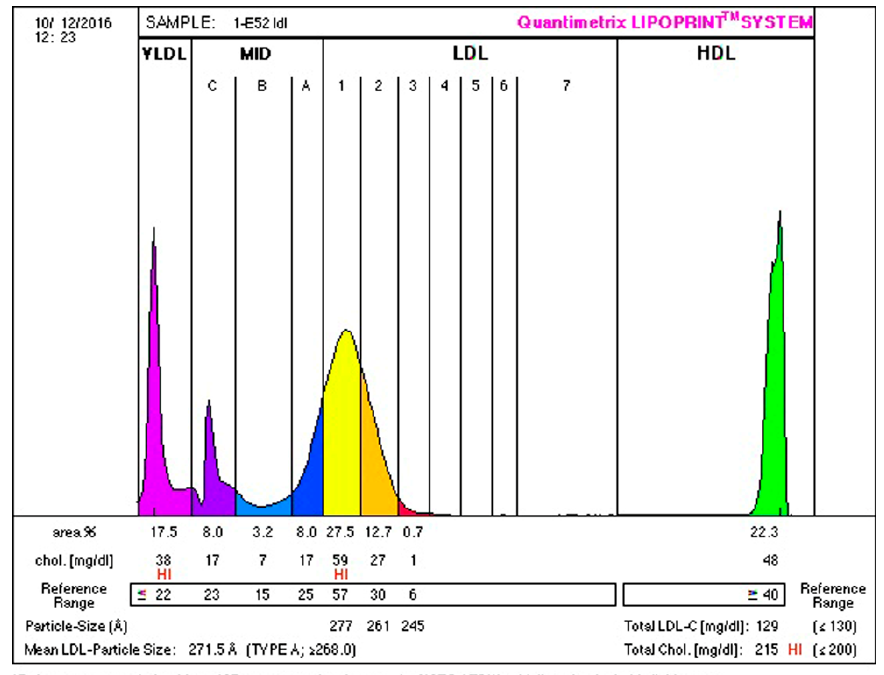
Figure 3. Low-density lipoprotein cholesterol (LDL-C) separation before therapy, indicating 17.5% of very-low-density lipoprotein (VLDL; purple), 19.2% of intermediate-density lipoprotein (IDL; blue), 40.2% of large (yellow and orange), 0.7% of small (red) LDL sub-fractions, and 22.3% of HDL